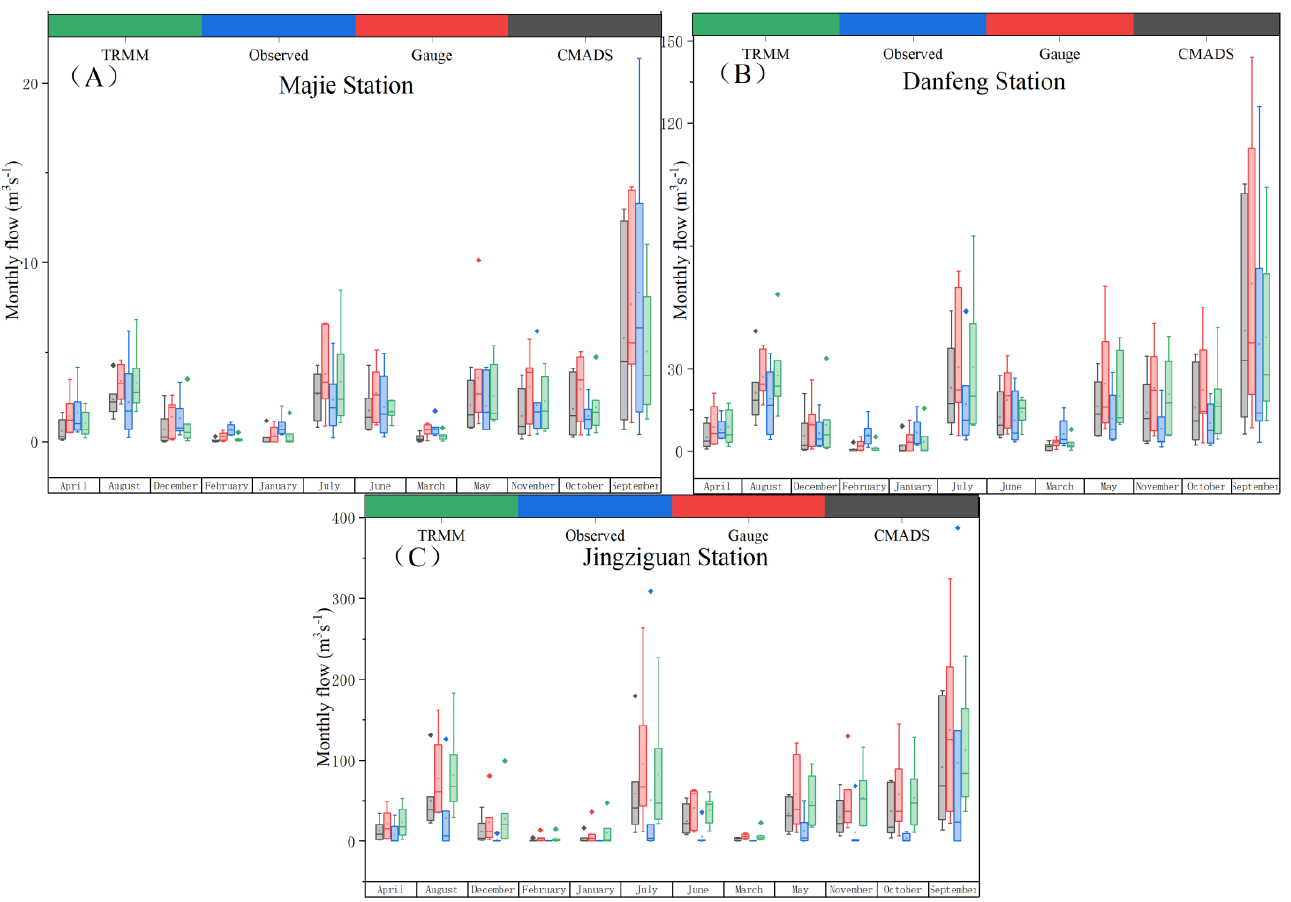
Figure 7. Box plot of the monthly runoff from 2006 to 2015, observed data and simulated stream- flow using CMADS, TRMM, and Gauge data at ( A ) Majie Station, ( B ) Danfeng Station, and ( C ) Jingziguan Station.